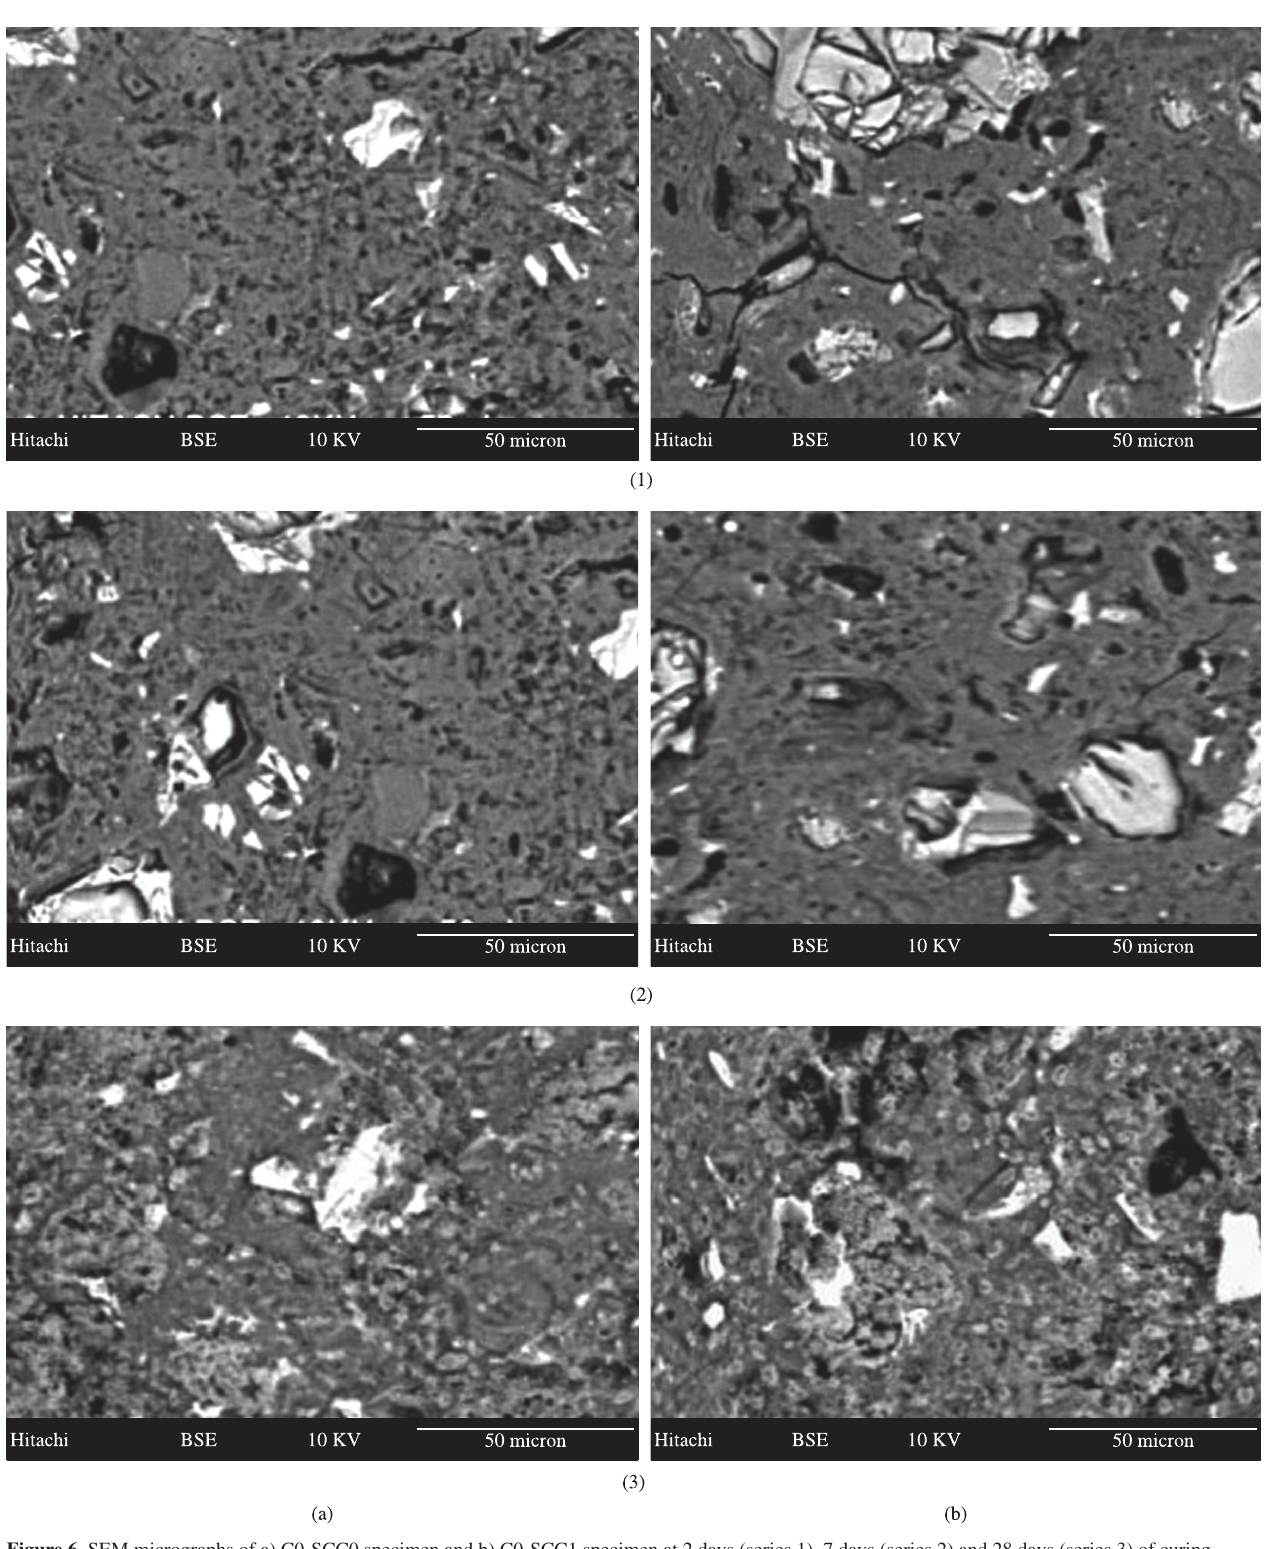
Figure 6. SEM micrographs of a) C0-SCC0 specimen and b) C0-SCC1 specimen at 2 days (series 1), 7 days (series 2) and 28 days (series 3) of